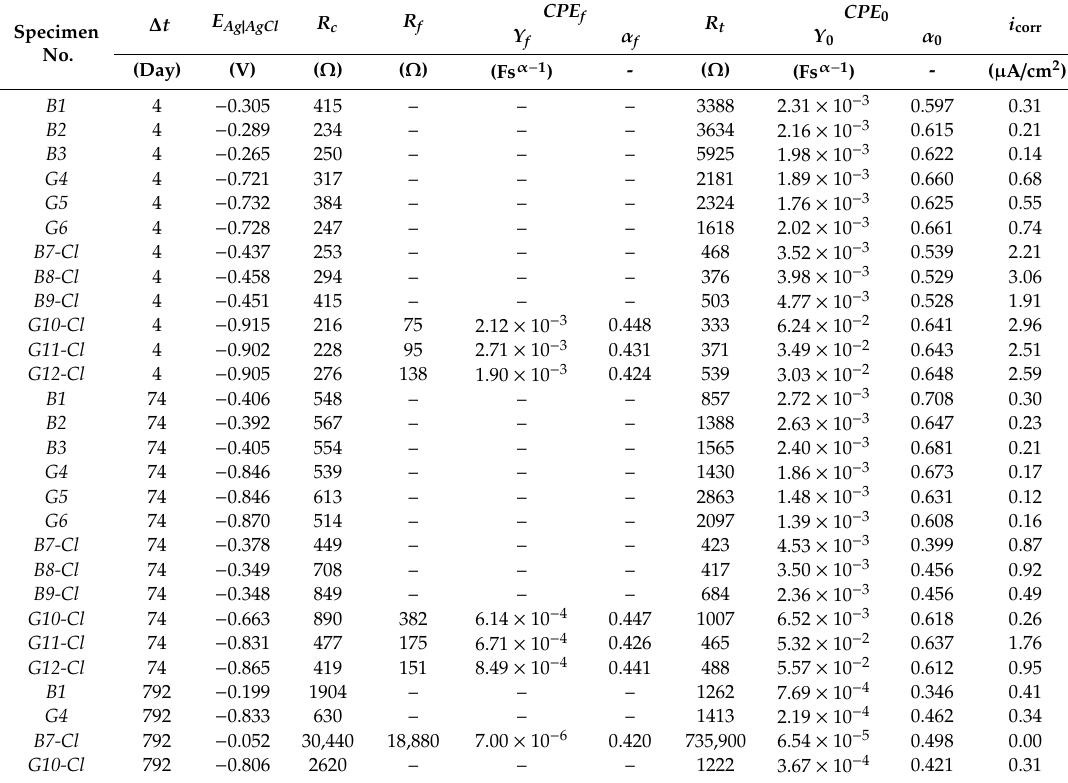
Table A2. Comparison of results from analyzing impedance spectra of reinforcing steel in concrete, obtained for three selected measuring series on day 4, 74, and 792. Specimen